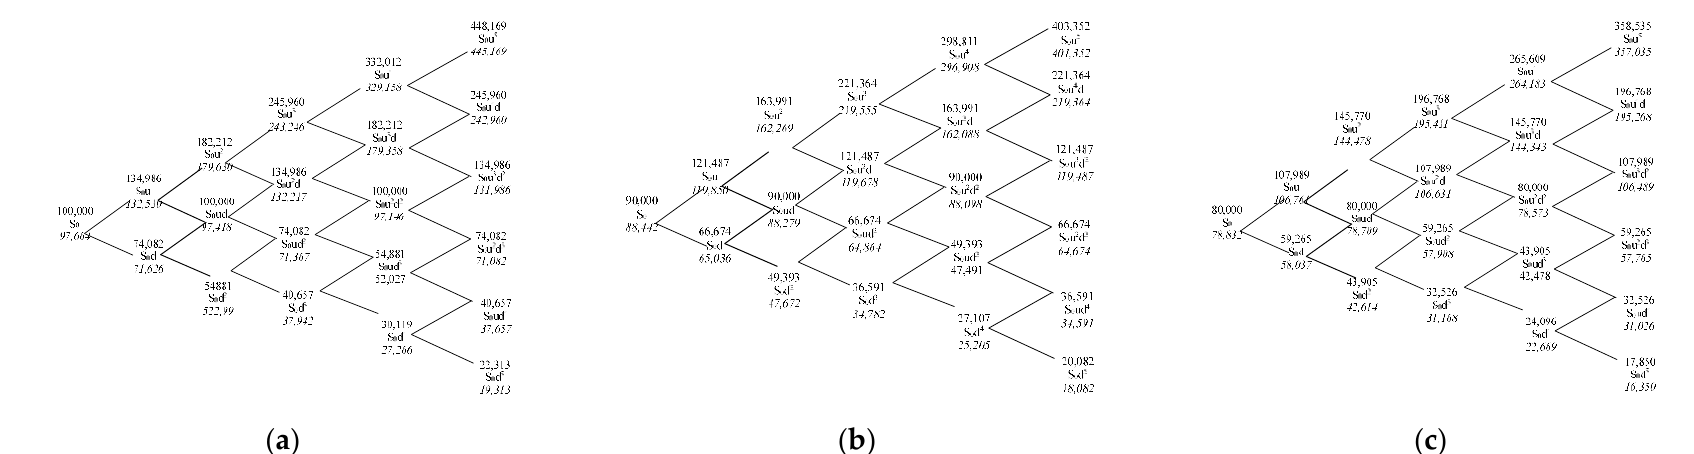
Figure A1. Option Value Binomial Tree for company ( a ) S, ( b ) W, and ( c ) B. Remarks: All numbers are thousands USD. Top numbers are asset values. Bottom italicized numbers are option values. Option to invest is exercised at notes where the option value is not zero.